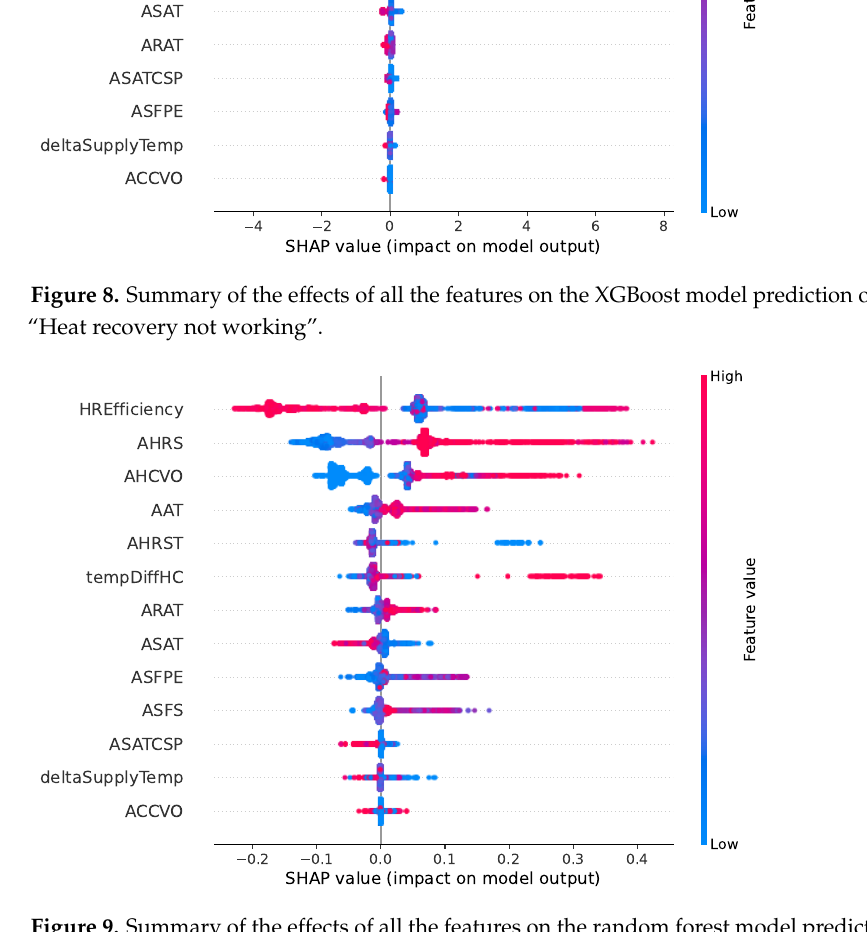
Figure 9. Summary of the effects of all the features on the random forest model prediction of the fault type “Heat recovery not